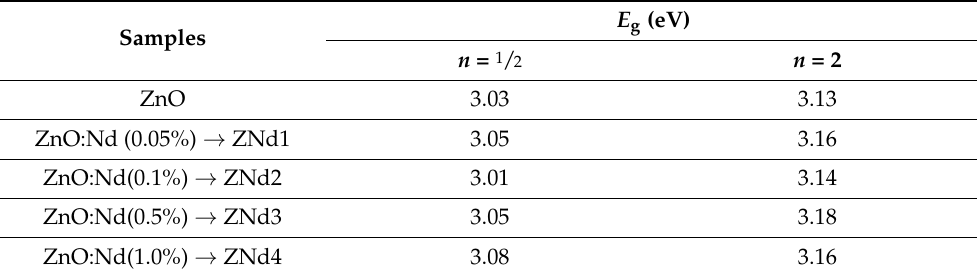
Figure 5. Diffuse reflectance spectra ( a ), [ F ( R ∞ ) h ν ] 2 ( b ), [ F ( R ∞ ) h ν ] 1 2 ( c ) plotted against photon Figure 5. Di ff use re fl ectance spectra ( a ), (cid:4670)𝐹(𝑅 (cid:2998) )ℎ𝜈(cid:4671) (cid:2870) ( b ), (cid:4670)𝐹(𝑅 (cid:2998) )ℎ𝜈(cid:4671) energy ( h ν ) for pure ZnO and Nd-doped ZnO nanostructured materials. ergy ( ℎ𝜈 ) for pure ZnO and Nd-doped ZnO nanostructured materials. Table 1. Optical band gap ( E g , eV) values of the prepared Table 1. Optical band gap ( E g , eV) values of the prepared materials.